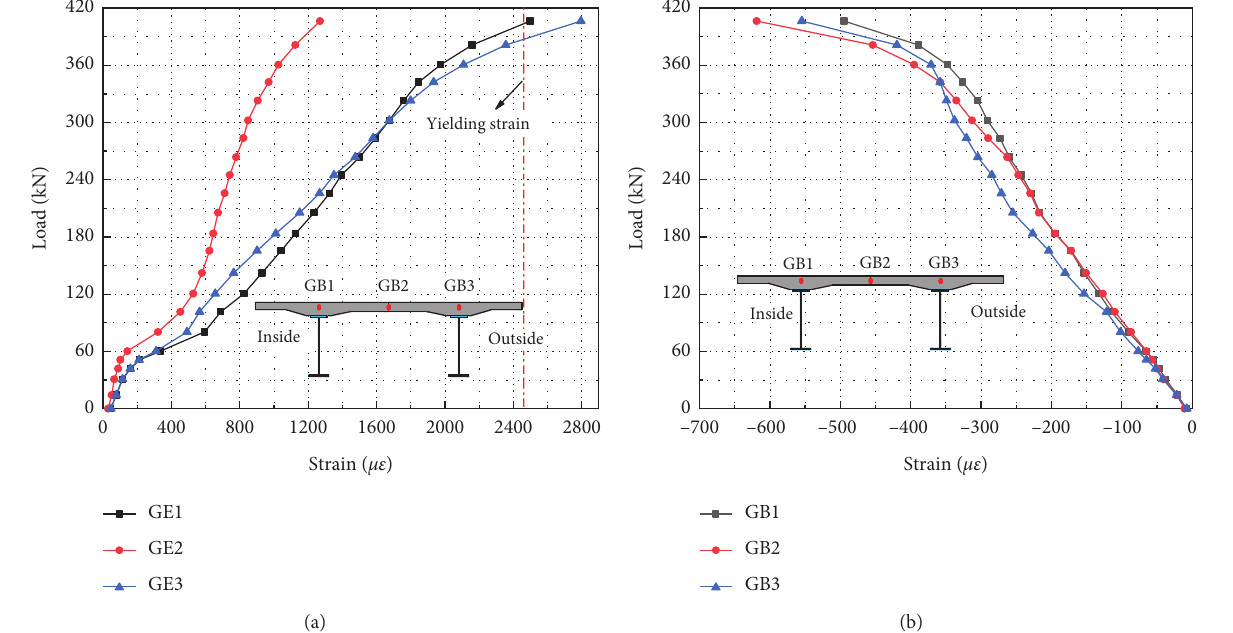
Figure 14: Load-strain curves of longitudinal reinforcement. (a) At the intermediate support section. (b) At the loading section.